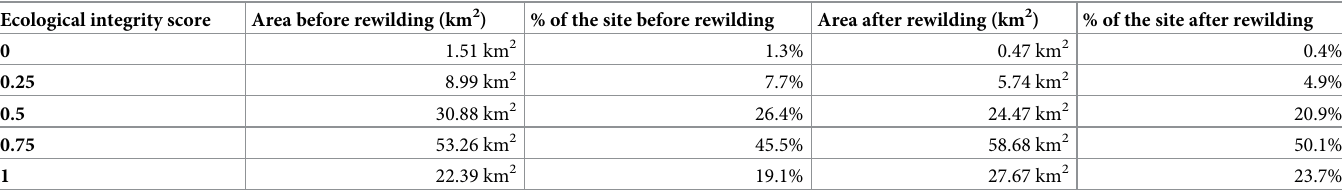
Table 4. Ecological integrity